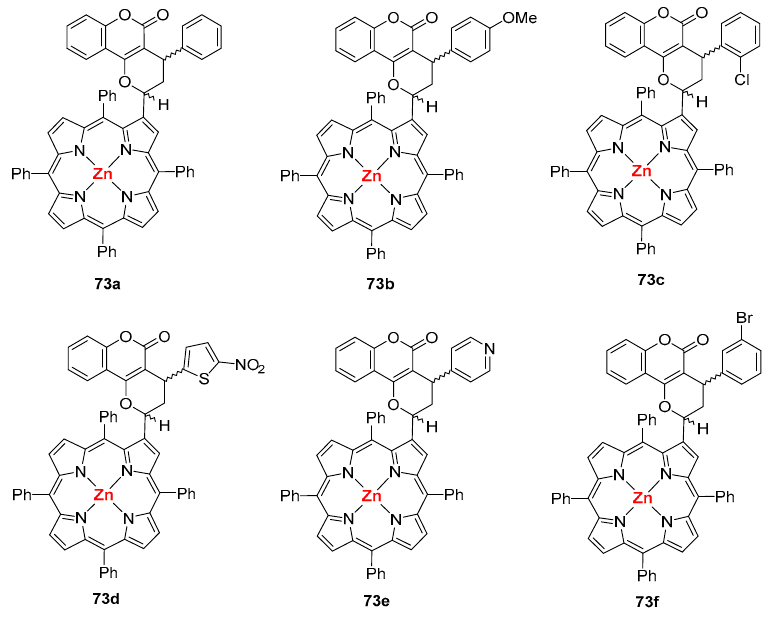
Figure 15. Dyads obtained from Zn 31 and various ortho -quinone methides [140].